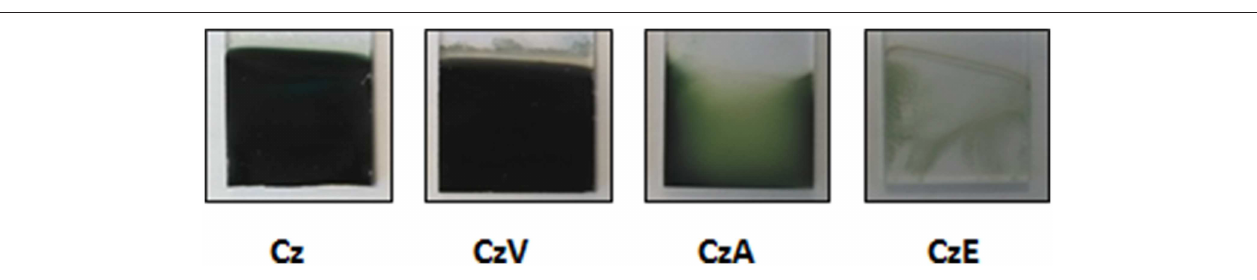
FIGURE 9 | Photographs of samples obtained by oxidation of 10 − 2 M Cz, CzV, CzA, and CzE in an acetonitrile solution (containing 0.1M LiClO 4